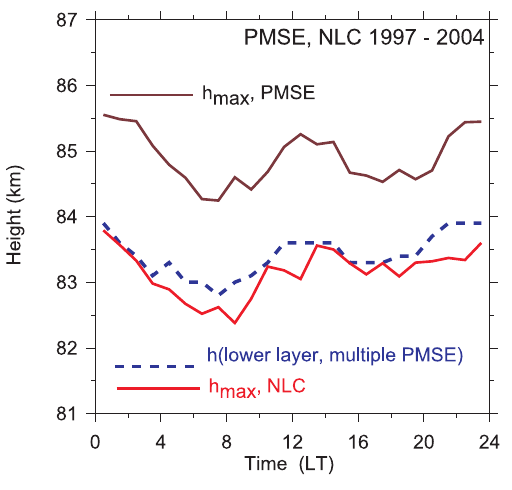
Fig. 4. Diurnal variation of the lower layer in the case of multiple PMSE layers (blue line) in comparison with the diurnal variations of all PMSE (black line) and NLC (red